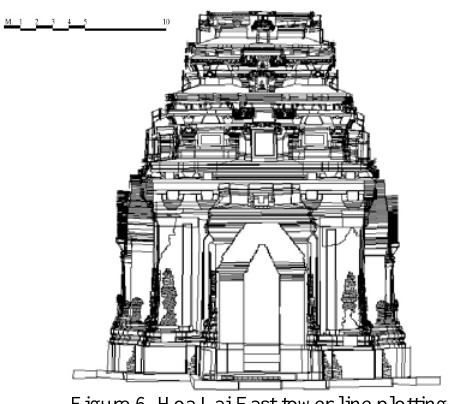
Figure 6. Hoa Lai East tower line plotting